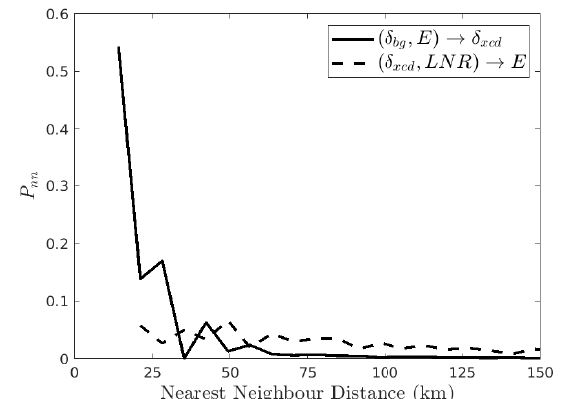
Figure 12. Nearest neighbor distribution P nn (using all observations in December 2012). Solid line: distance from points ( δ bg , E ) to the nearest δ xcd . Dashed line: distance from points ( δ xcd , LNR ) to nearest rain extreme E . Here δ xcd = δ xc ∪ δ xd , and LNR = L ∪ NR .